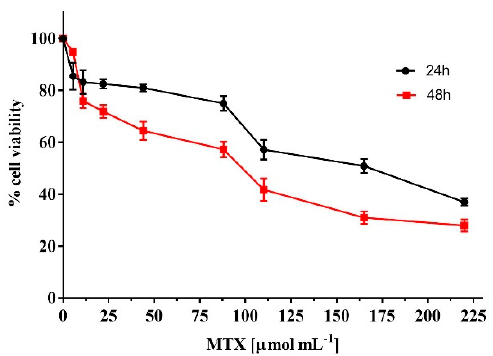
Figure 7. MCF-7 cells treated with increasing concentrations of methotrexate (MTX) for 24 or 48 h.